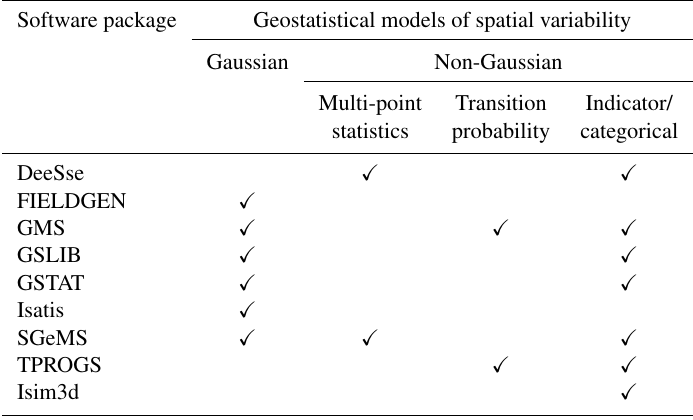
Table 2. Popular methods for simulating spatial variability of hydrogeological properties and their implementation in software packages (area 1). Additional options for random field generation are discussed here: https://petrowiki.org/Geostatistical_conditional_simulation\T1\ textbackslash#Sequential_simulation (last access: 12 December